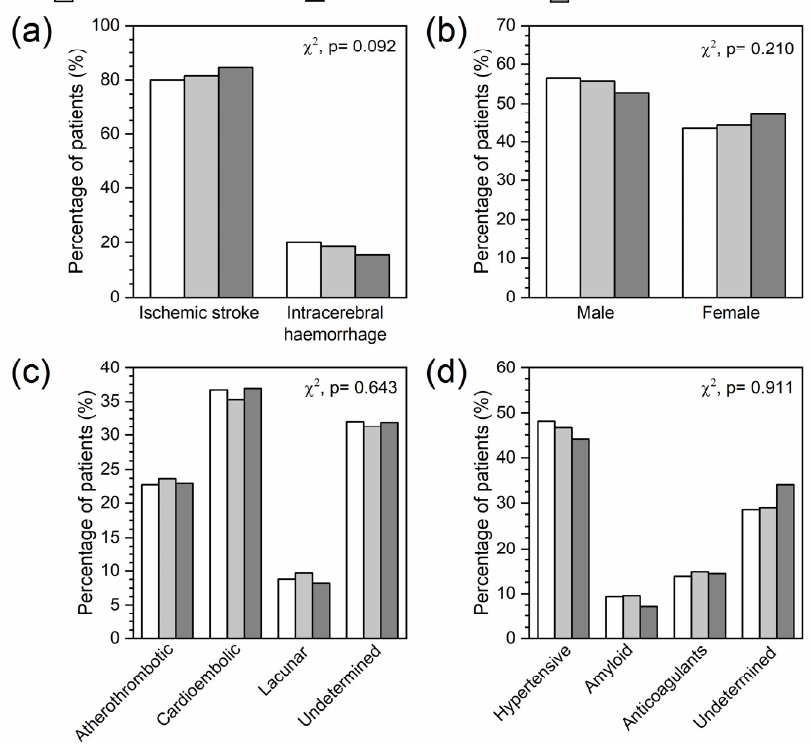
Figure 3. Relationship between stroke time and ( a ) type of stroke, ( b ) gender and etiology of ( c ) ischemic stroke and ( d ) intracerebral haemorrhage.